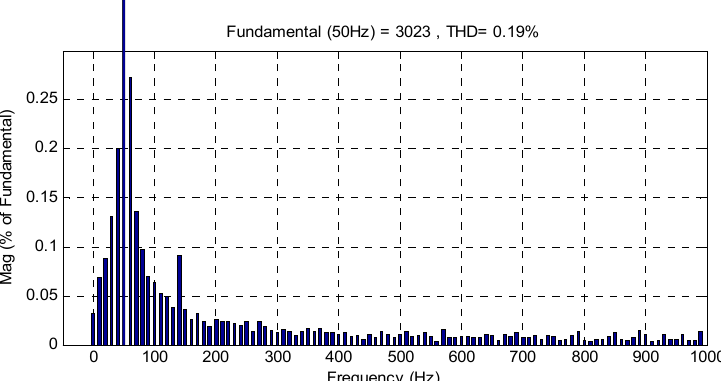
Figure 7. THD value of the stator current (DFTC-TOSMC).